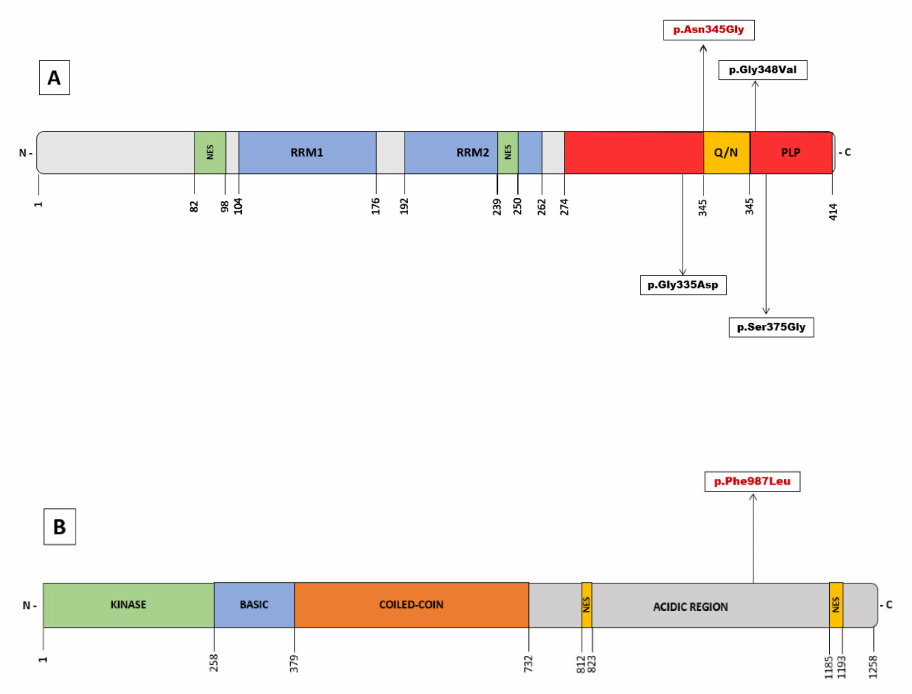
Figure 2. ( A ) Overview of pathogenic variants in TARDBP identified in Juvenil ALS. Schematic domain structure of TAR DNA-binding protein 43 (TDP-43). ( B ) Schematic representation of the NEK1 protein structure with the identified variant of uncertain significance. The numbers represent amino acid